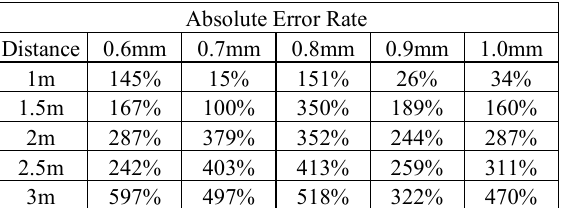
Table 11. The absolute error rates for each